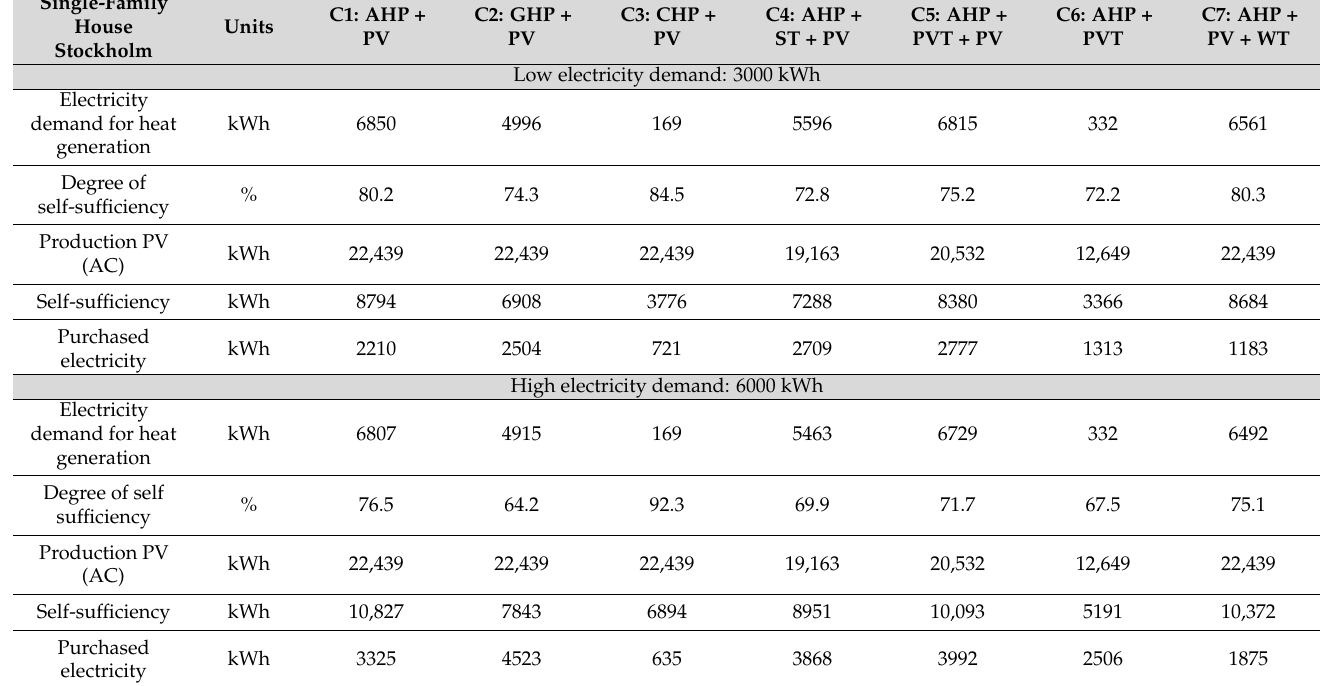
Table 4. Results of the Polysun simulation for the single-family house in Stockholm, Sweden. Single-Family